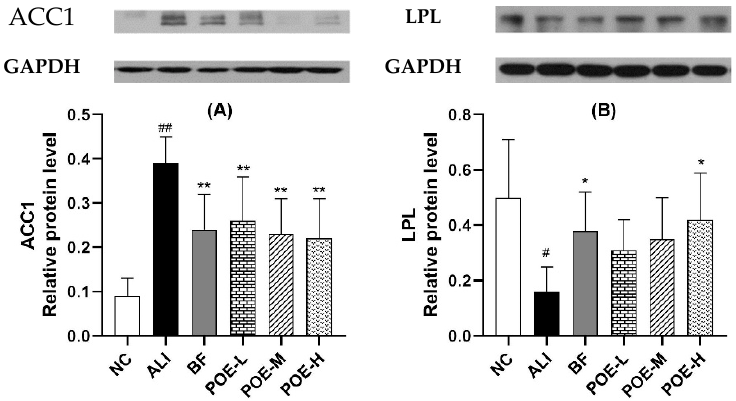
Figure 6. Effects of POE on the protein expression of ACC1 and LPL in liver of rats with alcoholic liver injury. ( A ) the protein expression of ACC1, ( B ) the protein expression of LPL. Values are presented as Mean ± SEM, n = 6. # p < 0.05 and ## p < 0.01 vs. NC group. * p < 0.05 and ** p < 0.01 vs. ALI group.